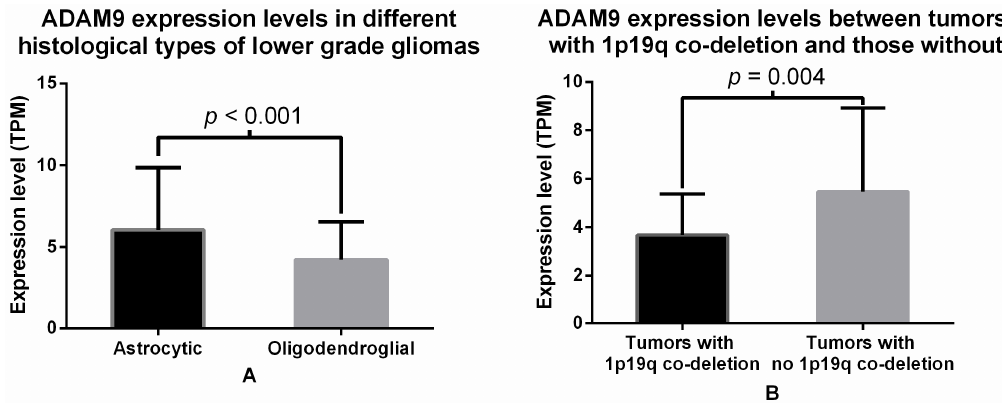
Figure 2. ( A ) Comparison of ADAM9 mRNA expression levels between LGG tumor samples with